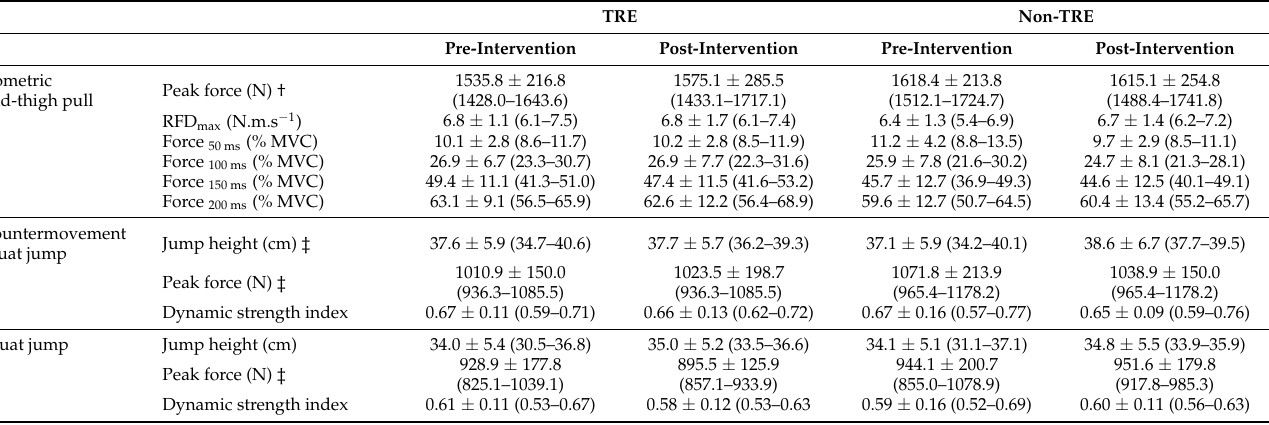
Table 3. Changes in indices of muscle strength (lower limb) after 30 days of time-restricted eating (TRE) and habitual diet